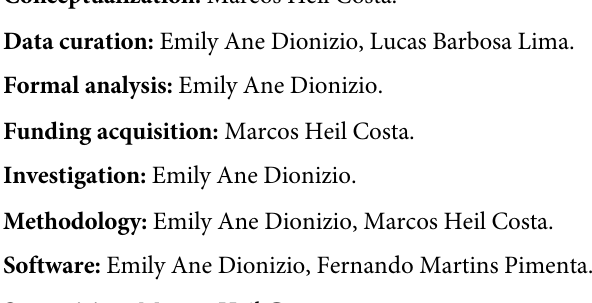
S1 Table. Additional information of experiment samples. Geographic coordinates, and organic soil carbon for depths 0-5, 5-10, 10-15, 15-20, 20-40, 40-60, and 60-100 cm, for each sampling